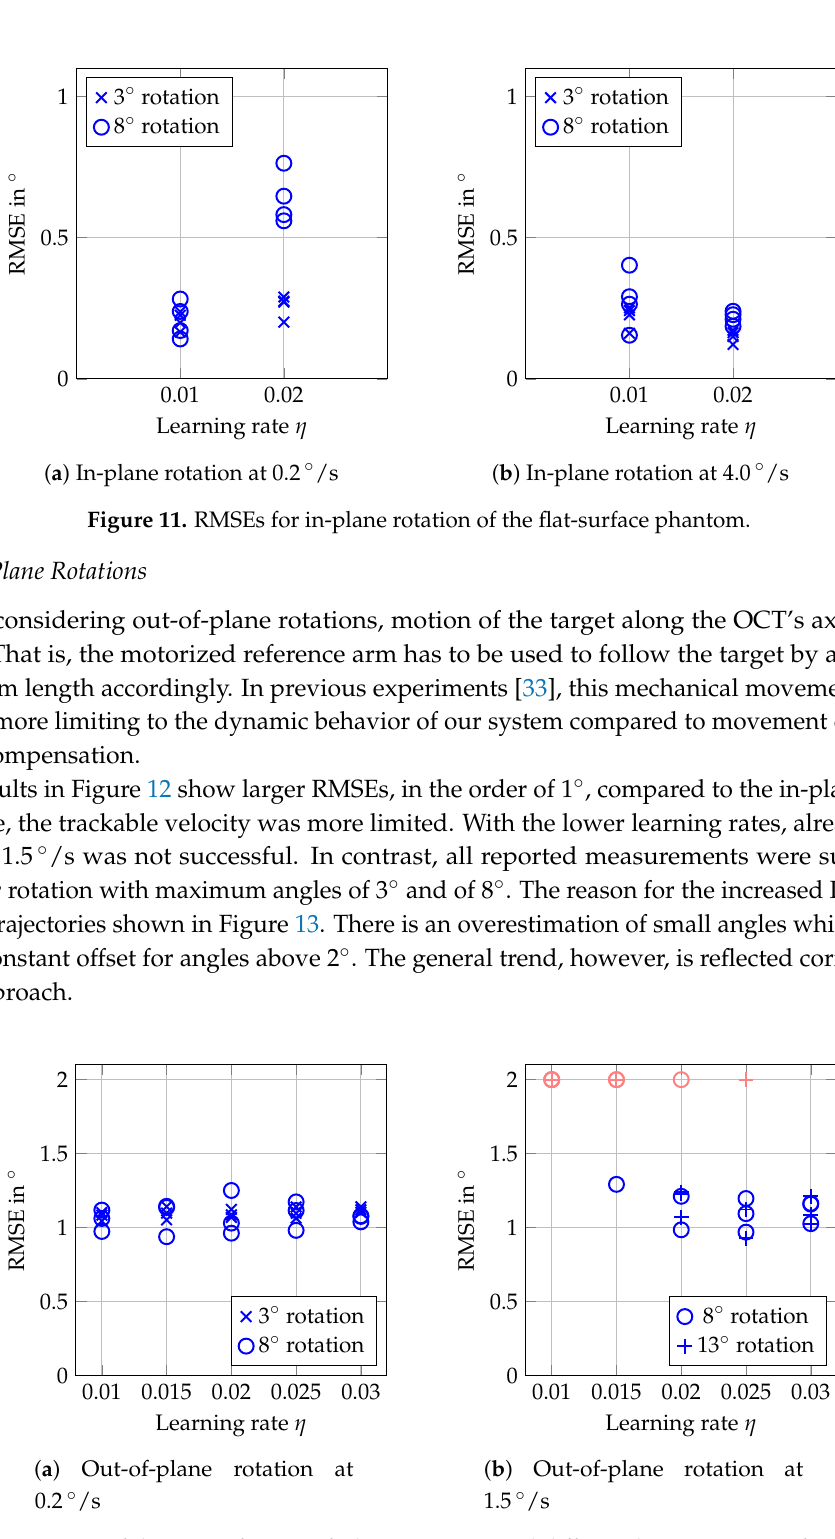
Figure 12. RMSEs of the errors for out-of-plane rotations and different learning rates η from 0.01 to 0.03 of the MOSSE filter. Three repetitions were done for each combination, but RMSEs exceeding 2 ◦ are considered as failed tracking and indicated by red marks at 2 ◦